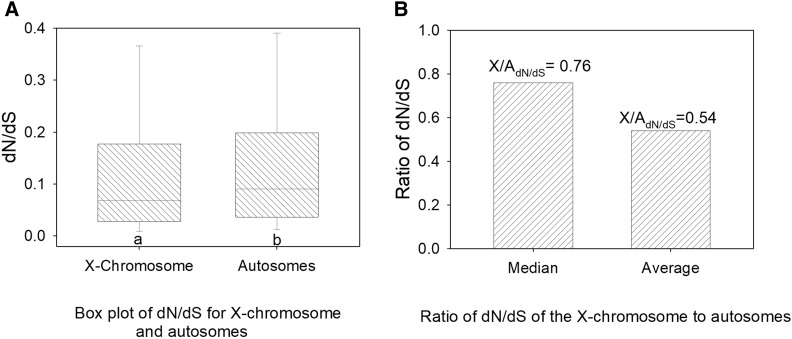
The dN/dS of genes located on the X chromosome vs. autosomes. A) Box plots of dN/dS showing the median, upper and lower quartiles, and 95/5th percentiles; B) the ratio of dN/dS for the X chromosome vs. the autosomes using the median and mean values per group. Different letters under bars in panel A indicate a statistically significant difference using Mann-Whitney U (MWU)-tests.